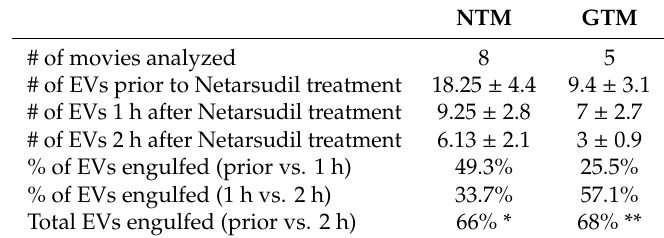
Table 2. Number of EVs in NTM and GTM cells immediately prior to treatment, and at 1 and 2 h